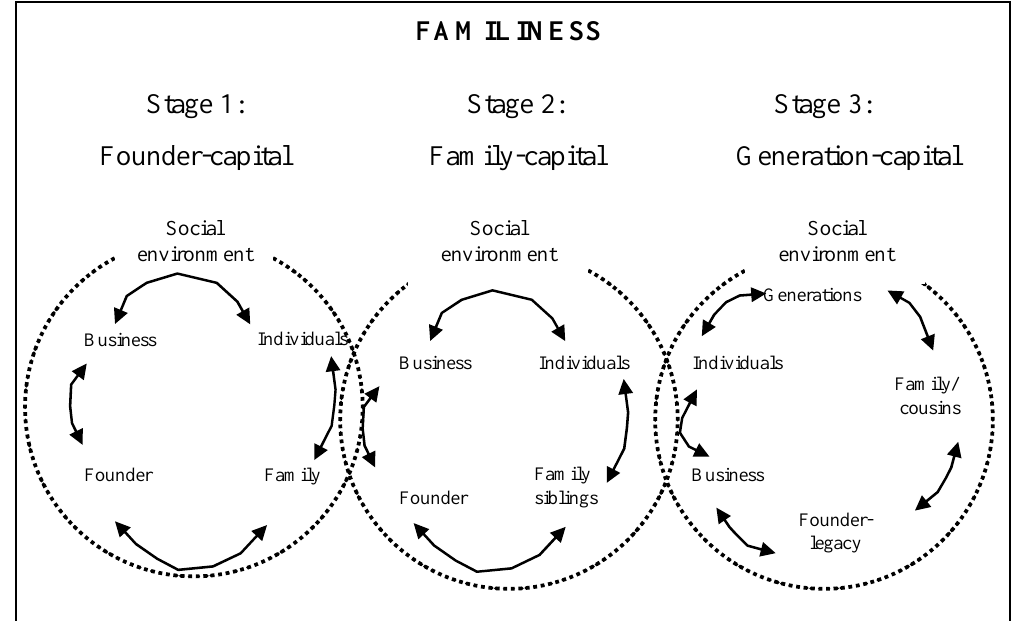
Figure 1: Evolution of family- business Source : Adapted from Venter, 2003: